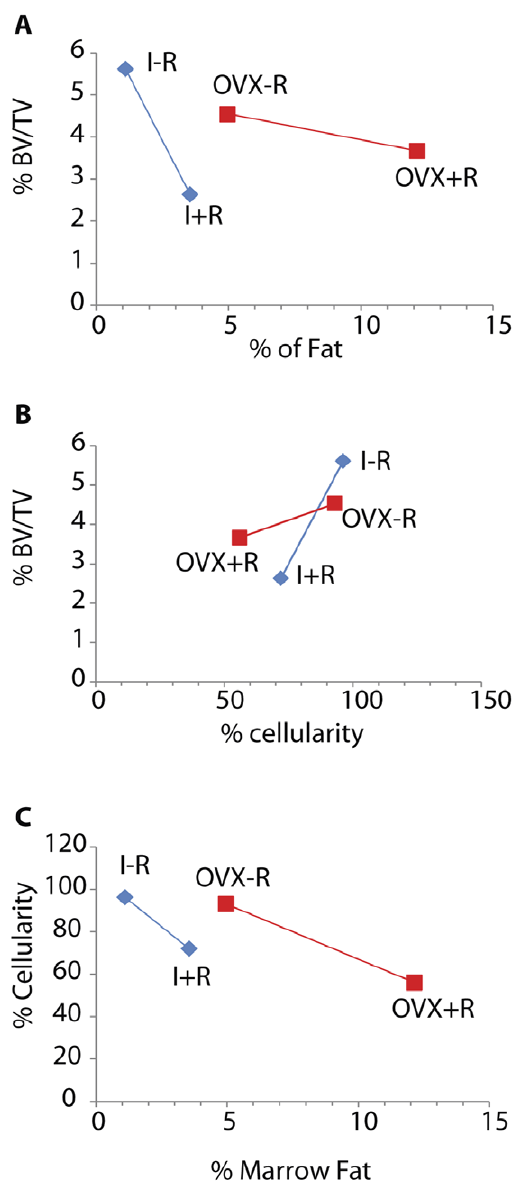
Figure 4. Ovariectomy influences the relationships between bone volume (BV/TV%), adipogenesis (% marrow fat), and hematopoiesis (% cellularity) at Day 30 with or without 16 Gy radiation to the hind limb in mice. Data of every two measurements are represented as least squares mean values for the group. Panel A: OVX results in a 10 fold reduction in the rate of bone volume loss per unit increase in marrow fat after radiation treatment compared with intact mice. Panel B: OVX blunts the rate of bone volume loss relative to reduced hematopoietic cellularity after radiation compared with intact mice by a factor of 6. Panel C: OVX halves the reduction in hematopoietic cellularity compared with increased marrow fat after radiation treatment compared with intact mice.